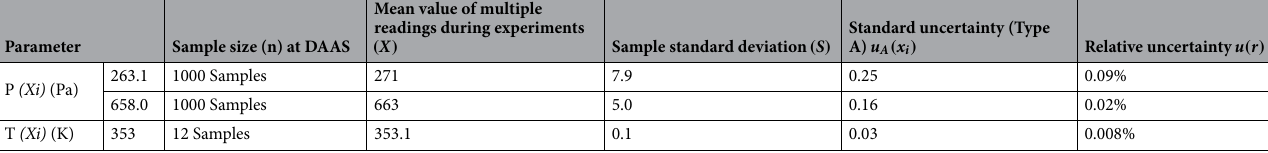
S and Relative uncertainty, u (r) in cavity pressure and iodine √ n =